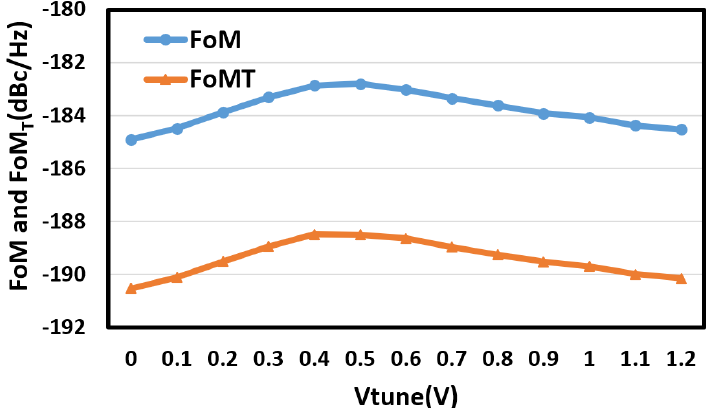
Figure 12. Phase noise vs. frequency.